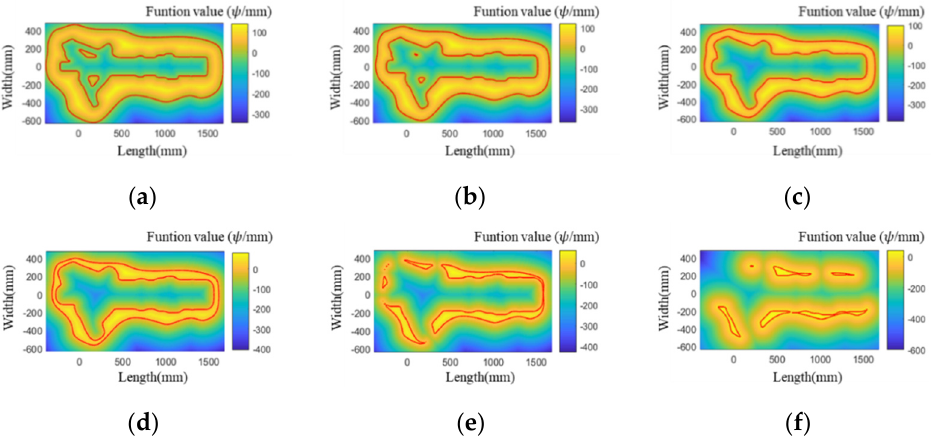
Figure 6. Contours and grids with different offset distances generated by using FDM: ( a ) 10 mm; ( b ) 30 mm; ( c ) 50 mm; ( d ) 70 mm; ( e ) 90 mm; ( f ) 110